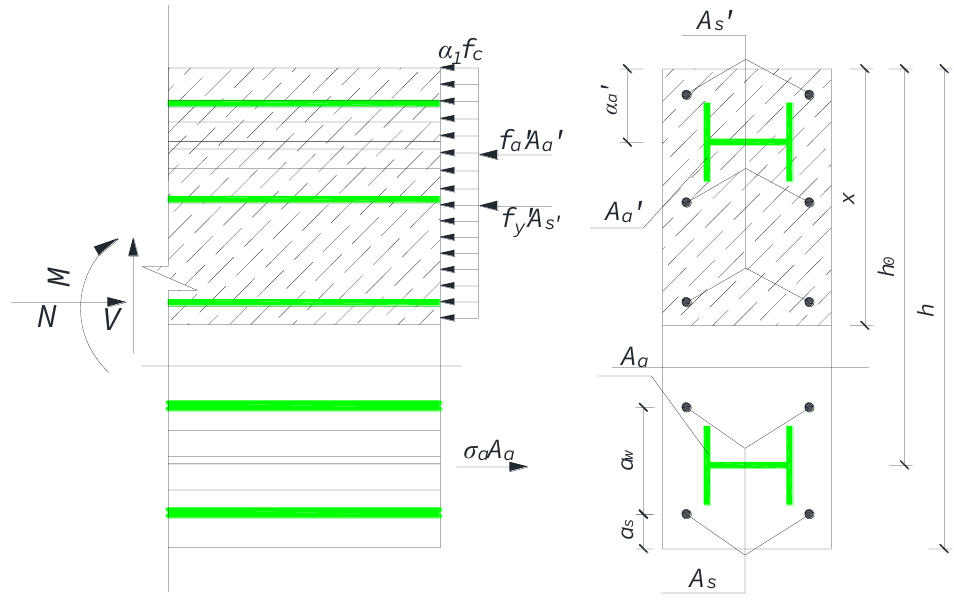
Figure 19. The Calculated Model of the Horizontal Ultimate Bearing Capacity.